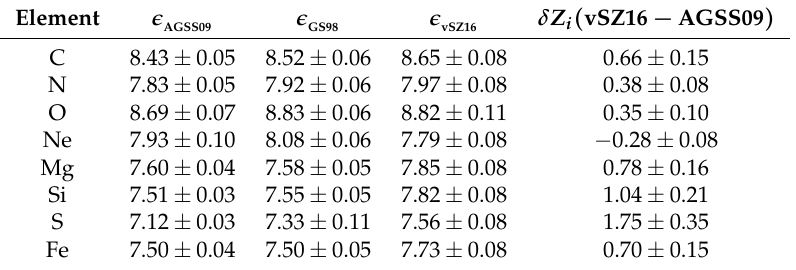
Table 1. Elemental abundances in the vSZ16, AGSS09, and GS98 catalogs and fractional variation between the vSZ16 and AGSS09 catalogs. Fractional variations between the vSZ16 and GS98 catalogs are not shown since only the AGSS09 catalogue is considered to be the “baseline” (and is more widely used by the community